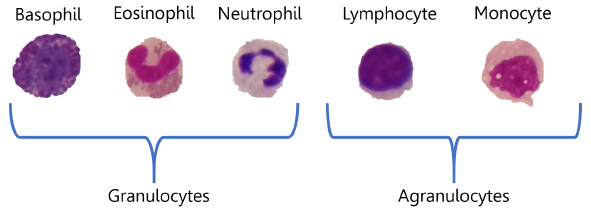
Figure 1. Representation of the WBC sub-types